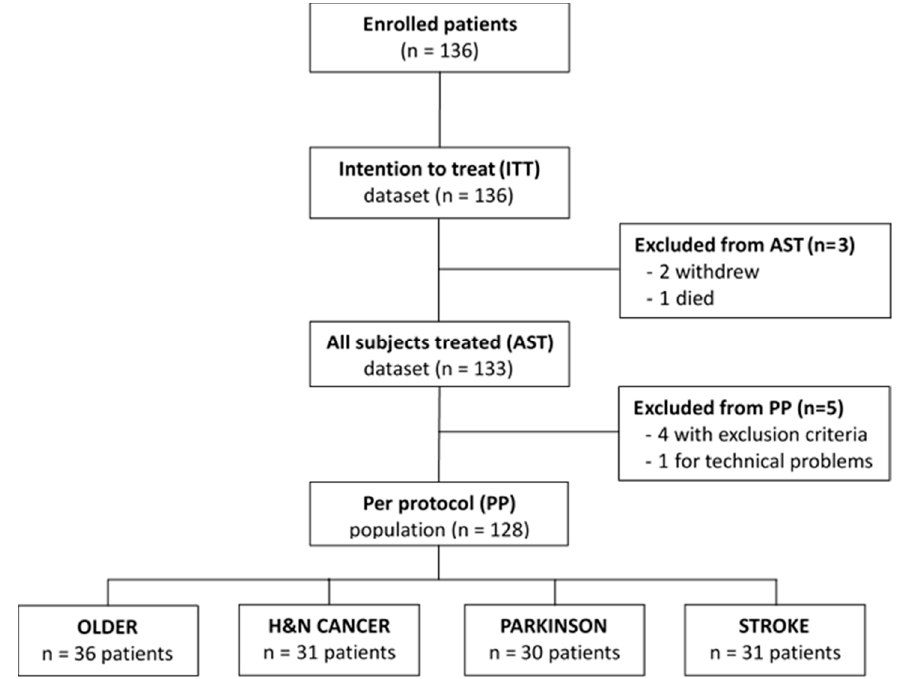
Figure 2. Study flow chart. Patients included in the study.